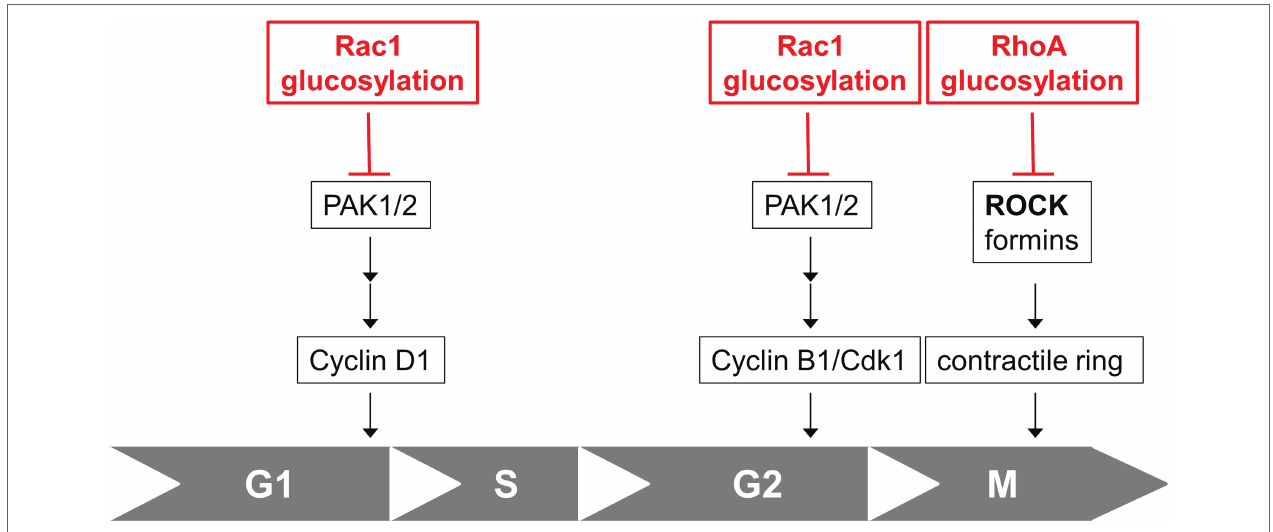
FIGURE 5 | Cell cycle effects of TcdB. Rac1 glucosylation by TcdB results in inhibition of Rac1/PAK-dependent pathways regulating expression of Cyclin D1 and subsequent arrested G1-S transition. Rac1 glucosylation by TcdB also results in inhibition of Rac1/PAK-dependent pathways leading to Cyclin B/Cdk1 complex and subsequent delayed G2-M transition. RhoA glucosylation by TcdB blocks formation of the contractile actin-myosin ring (CAR) in cytokinesis, resulting in arrested cell division in